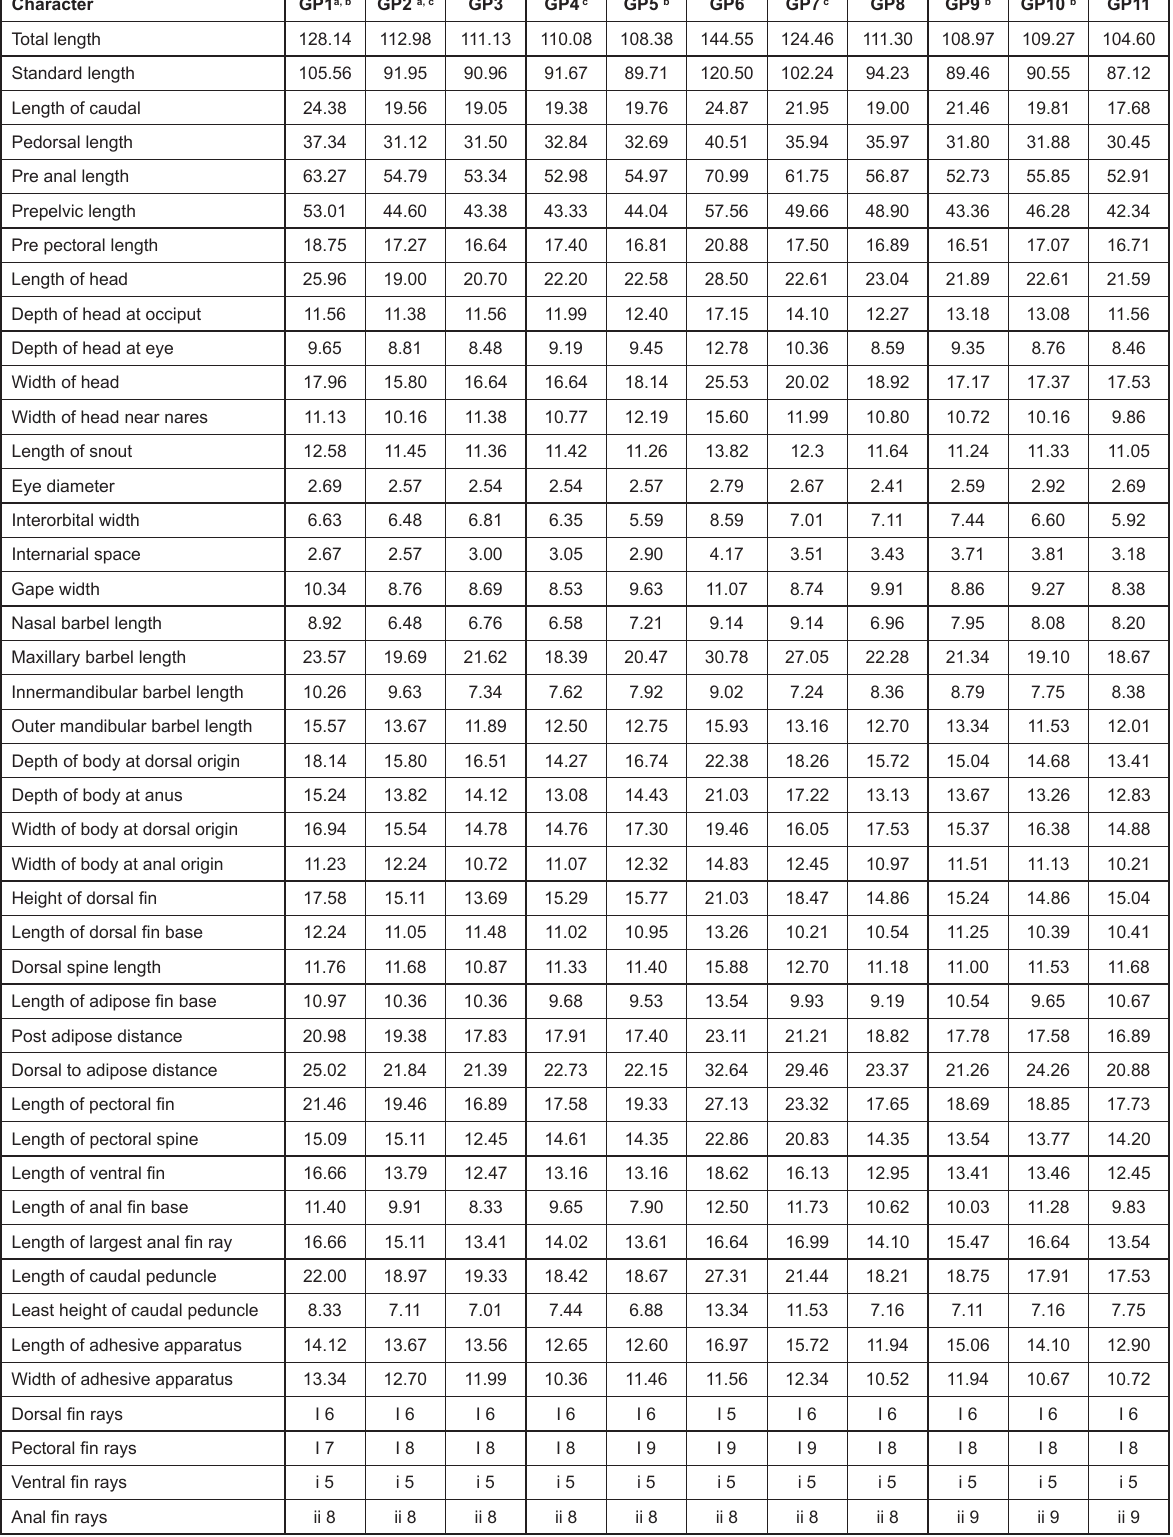
Table 4. Raw data of morphometric (mm) and meristic characters of Glyptothorax